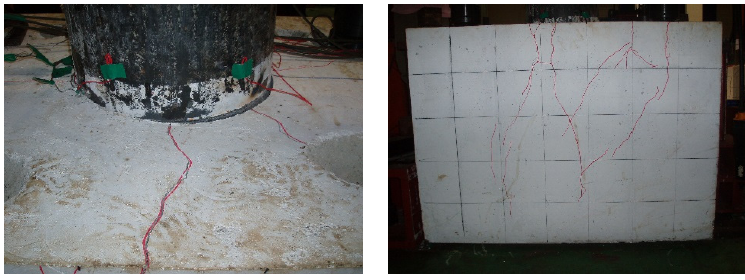
Figure 7. Failure mode of Specimen SB_D10_NL.